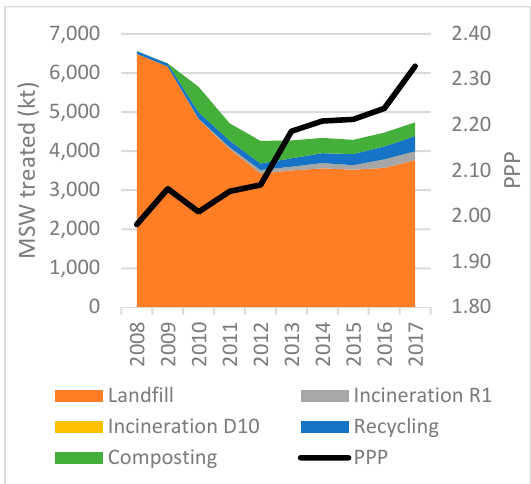
Figure 46. Waste treatment methods and PPP in Romania 2008–2017 (European Statistics 2019b, 2019c).